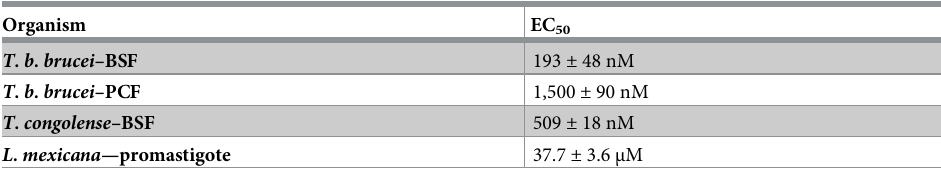
Table 1. EC 50 concentrations calculated by alamar Blue for several trypanosomatids.